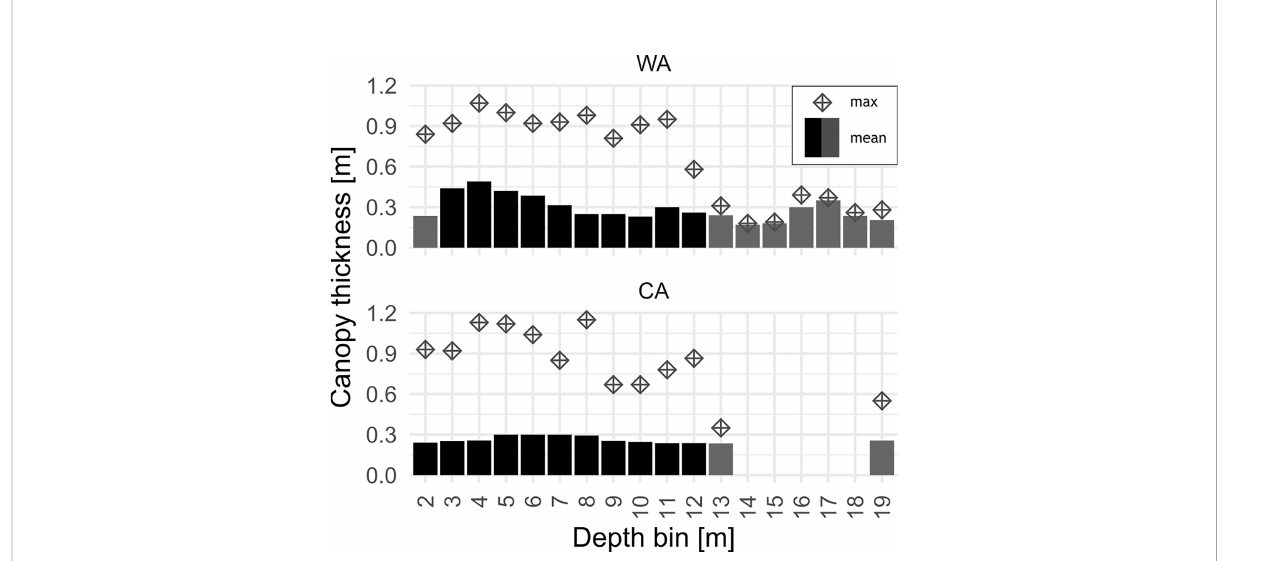
FIGURE 6 Canopy thickness in depth bins at each station: bars represents mean values, error bar — median canopy thickness and diamond point shows maximal value recorded in each bin. Bins with less than 100 observations were indicated by grey fi